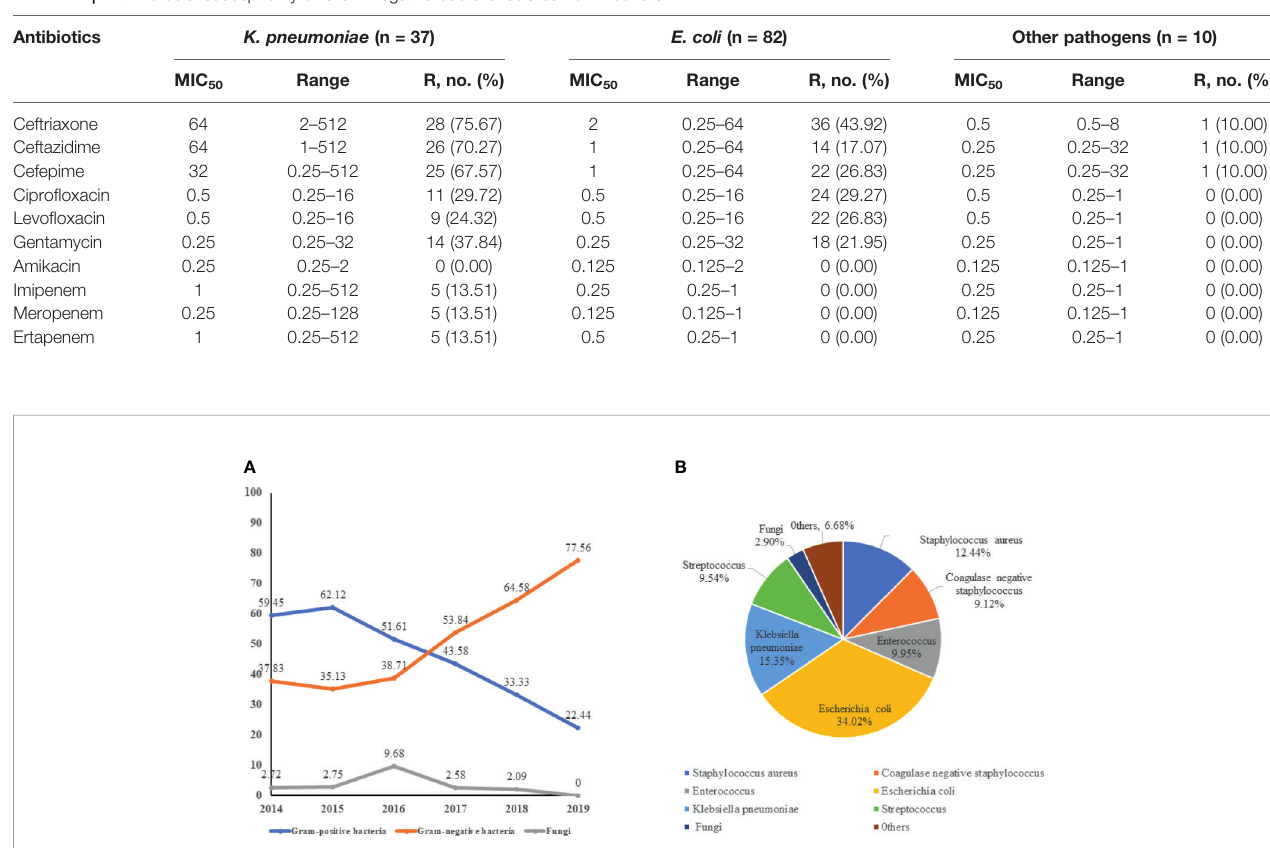
FIGURE 2 | The distribution of pathogen of neonatal bloodstream infection. (A) the trend of pathogen of neonatal bloodstream infection from 2014 to 2019. (B) the composition of bacteremia pathogens.